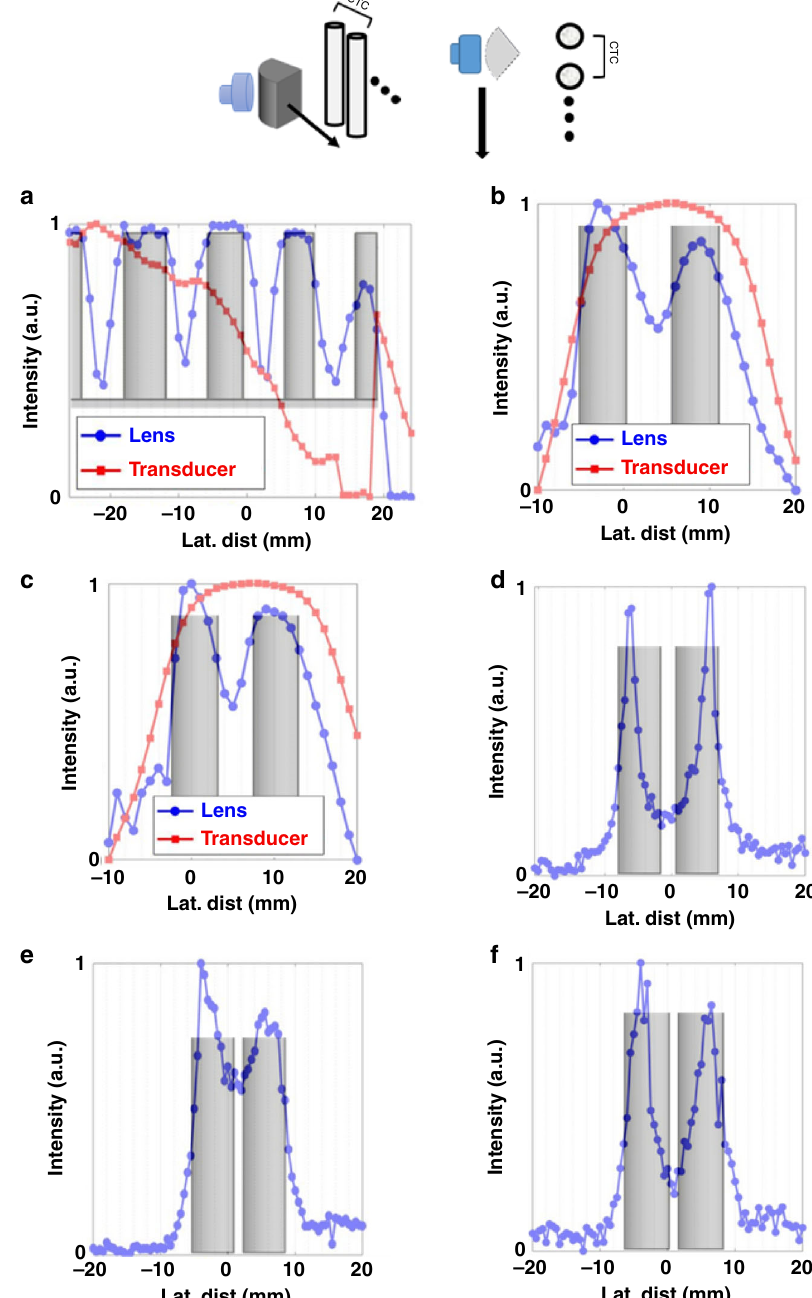
Fig. 2 Monostatic characterization of lateral resolving powers of metamaterial lens in water ambient with ABS 3D printed plastic rods. Intensity is stated for all in arbitrary units (a.u.). a Sample of equally spaced rods of decreasing diameter. Transducer alone does not clearly detect any of the rods. b , c Scan of 5 mm diameter rods with gaps of 5 mm ( b ) and 4 mm ( c ) between the boundaries. Only the ML shows the presence of more than one object. d – f Rods with subwavelength gap spacing of 0.69 λ ( d ), 0.47 λ ( e ), and 0.41 λ ( f